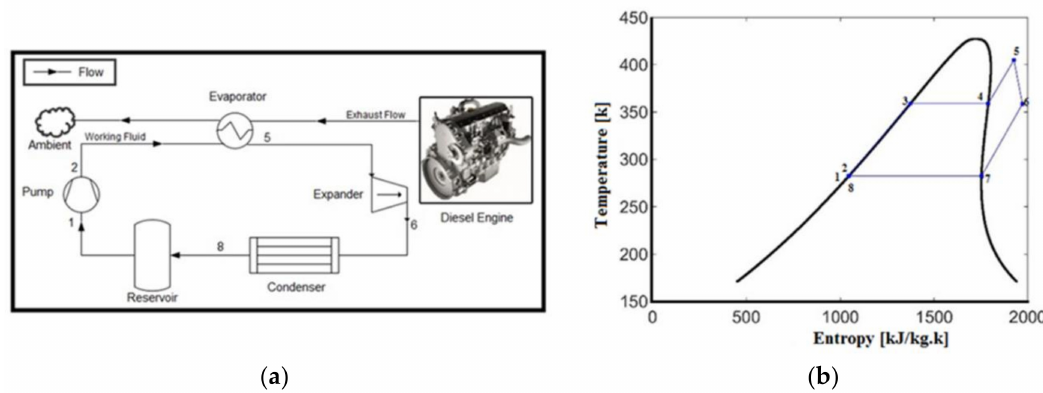
Figure 1. ( a ) Schematic representation of the ORC-ICE; ( b) Temperature-Entropy (T-s) diagram of cycle.